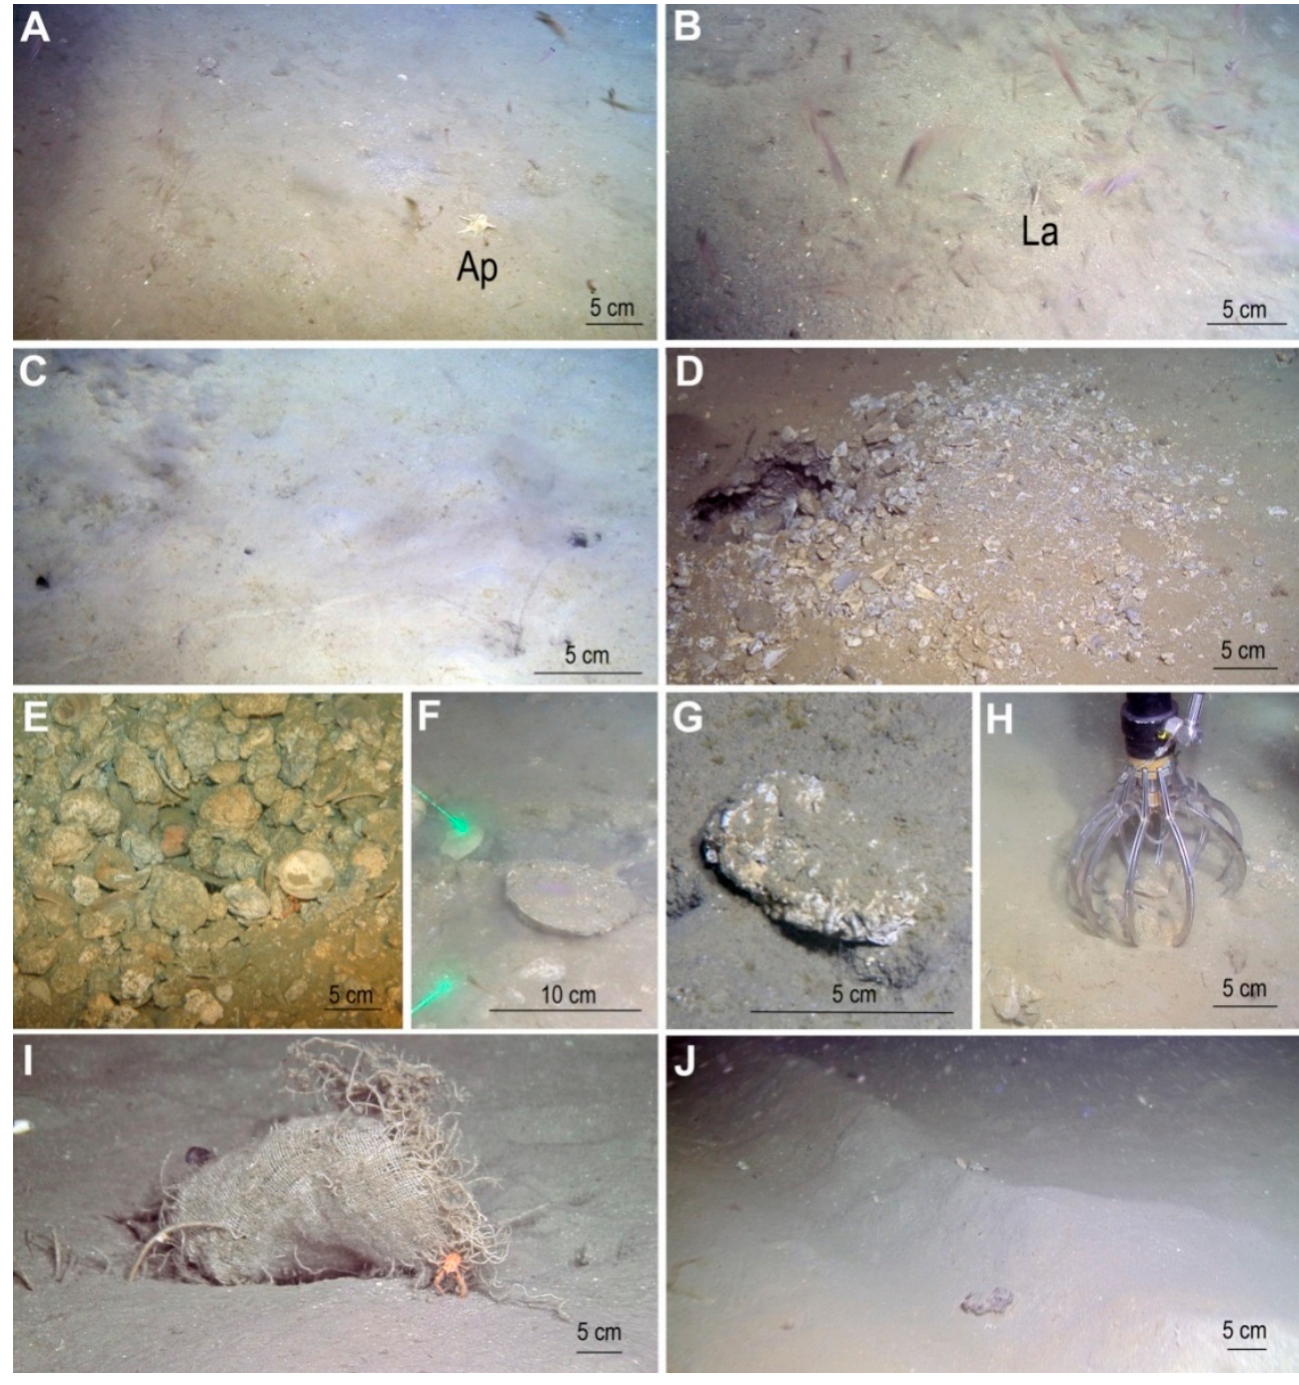
Figure 5. Some examples of present-day bottom sediments, fossil remains and anthropic activity indicators detected for the Alcántara ( A , B ), Málaga ( C – H ) and Aceitunas ( I , J ) carbonate mound fields of the northern Alboran Sea. ( A , B ) Muddy bottoms with some typical bathyal species, such as the gastropod Aporrhais serresiana (Ap) and the polychaete Lanice conchilega (La); ( C ) Bathyal muddy bottoms with burrowing megafauna (mainly Munida spp. and Nephrops norvegicus ); ( D – H ) rhodoliths and bivalve remains detected in several mounds; ( I ) a cloth sack over Spiochaetopterus sp. tubes and ( J ) a bottom-trawling mark. All underwater images obtained with ROV LIROPUS 2000, Instituto Español de Oceanografía (Spain), except figure E obtained with ROV CHEROKEE, Marum, Bremen (Germany).